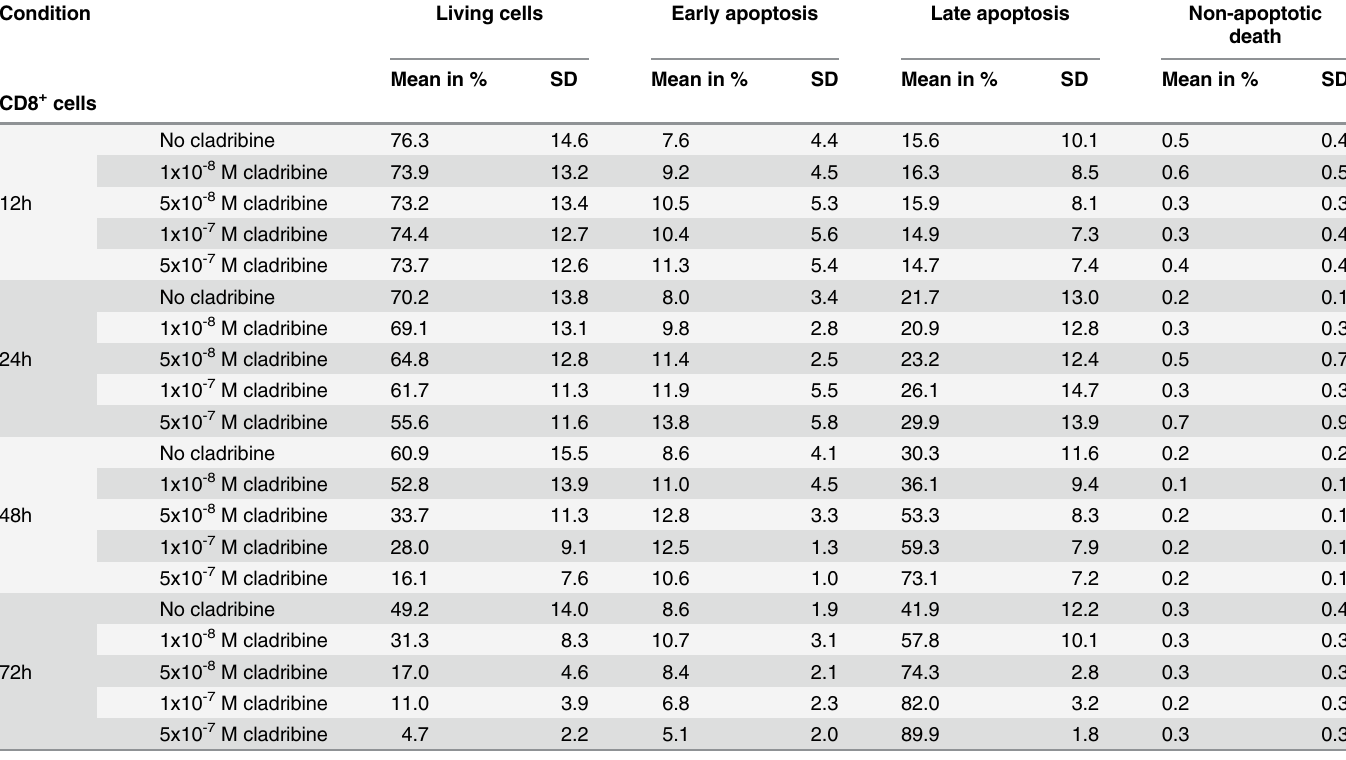
Table 3. Apoptosis of stimulated CD8 + cells caused by cladribine in vitro . Condition Living